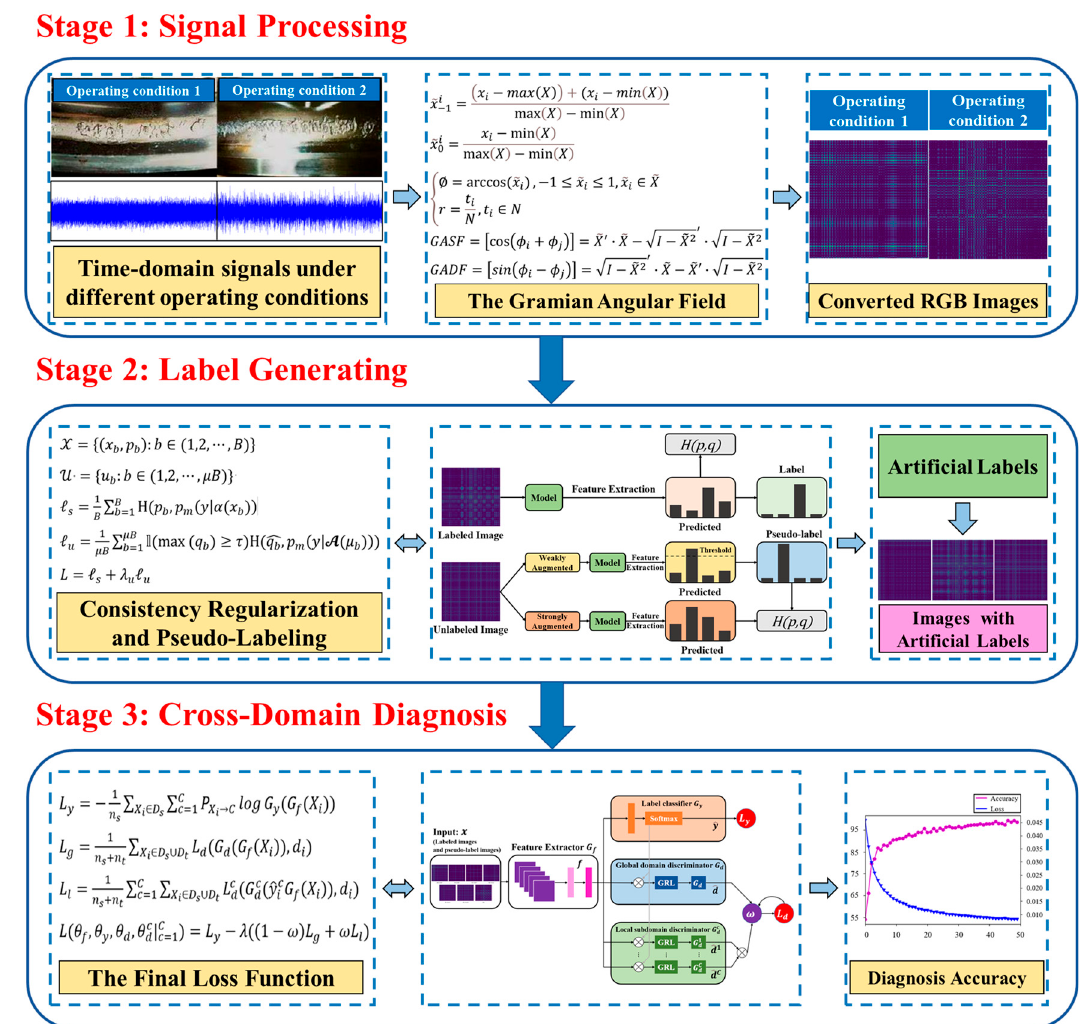
Figure 3. The flow diagram of the proposed approach.